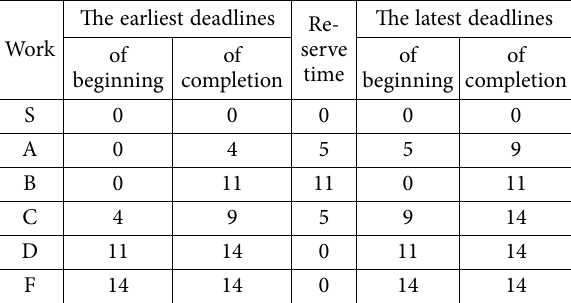
Table 2. The results of calculations of the earliest and the